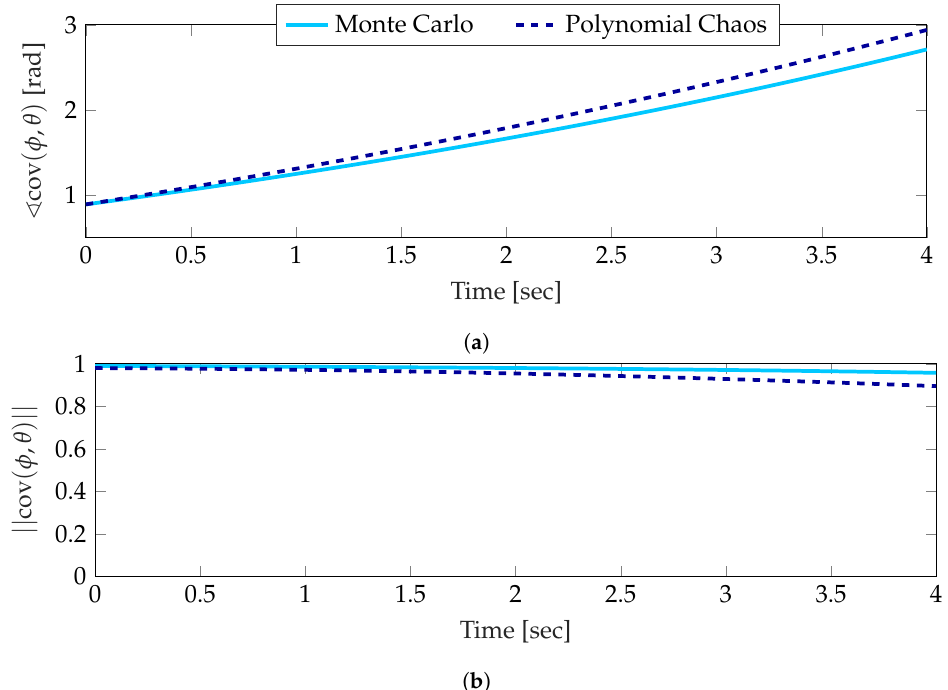
Figure 7. Estimation of the covariance between the two angles using a fifth order polynomial chaos expansion compared against Monte Carlo simulation. ( a ) Angle Component. ( b ) Length